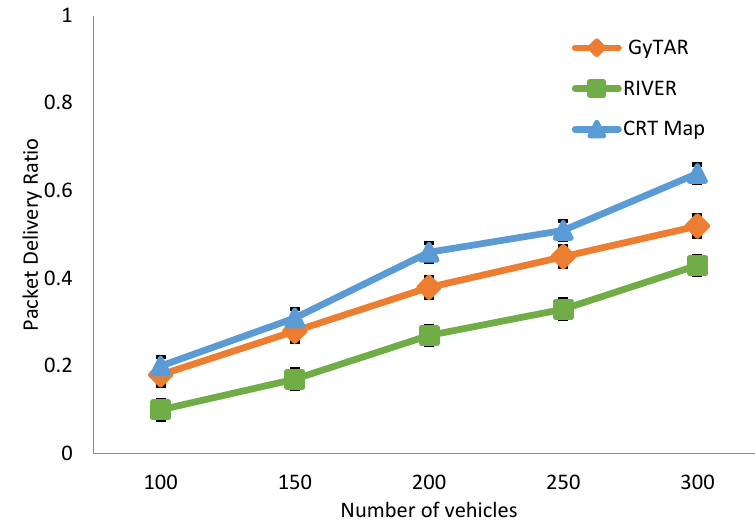
Figure 10. Packet delivery ratio vs. vehicular density.